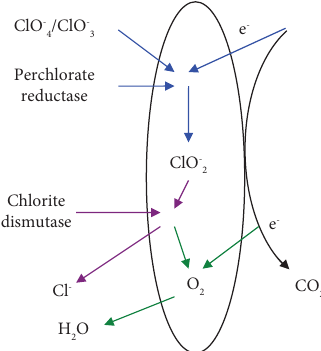
Figure 1: Pathway of perchlorate reduction by perchlorate- reducing bacteria as discussed by Trash et al.